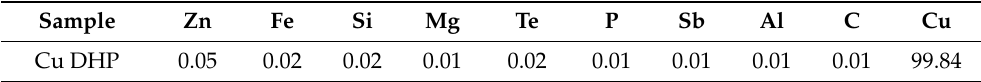
Table 1. Chemical composition of the Cu tubes in wt.%.